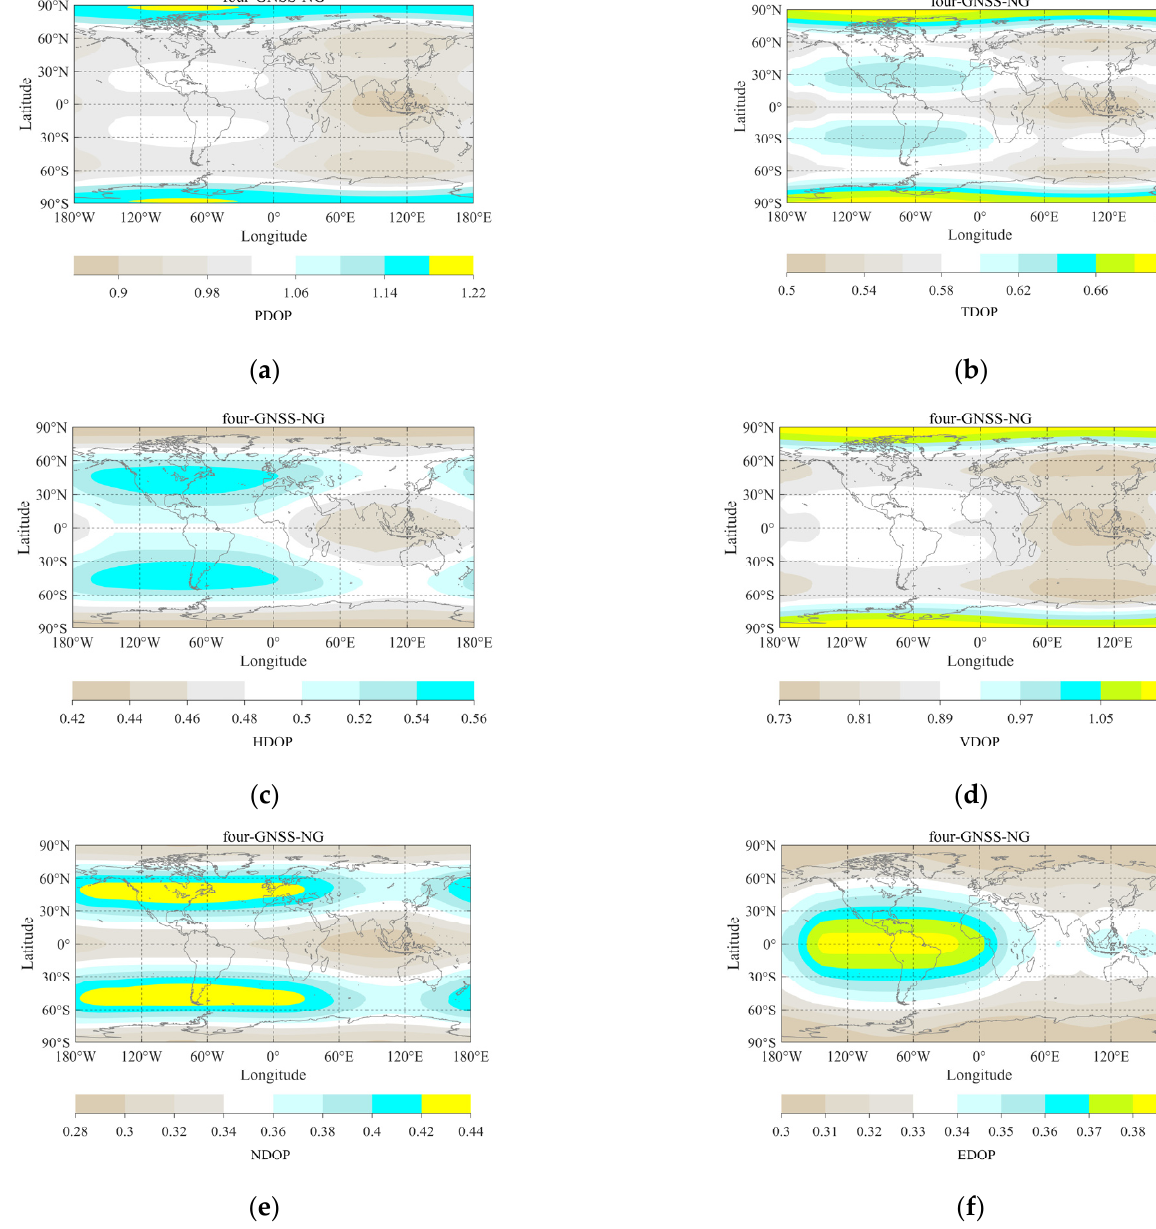
Figure 7. DOPs of four-GNSS-NG: ( a ) PDOP; ( b ) TDOP; ( c ) HDOP; ( d ) VDOP; ( e ) NDOP; ( f ) EDOP.